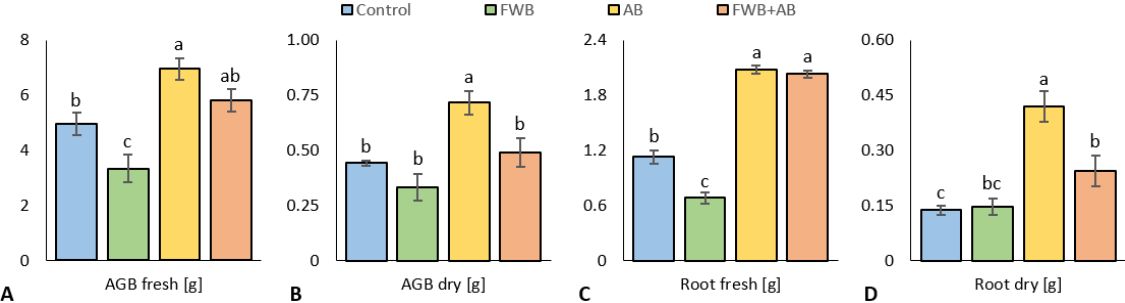
Figure 1. The responses of plant growth characteristics under the applied amendments on ( A ) above ground fresh biomass; ( B ) above ground dry biomass; ( C ) root fresh weight; and ( D ) root dry weight). Different lowercase letters indicate statistically significant differences within columns. n = 3.